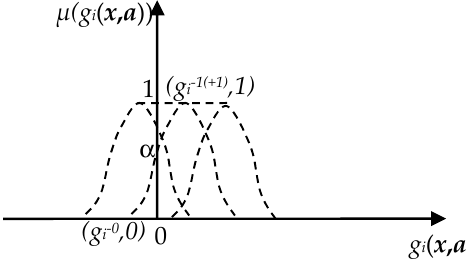
Figure 1. Normal membership function μ (g i ( x , a )).